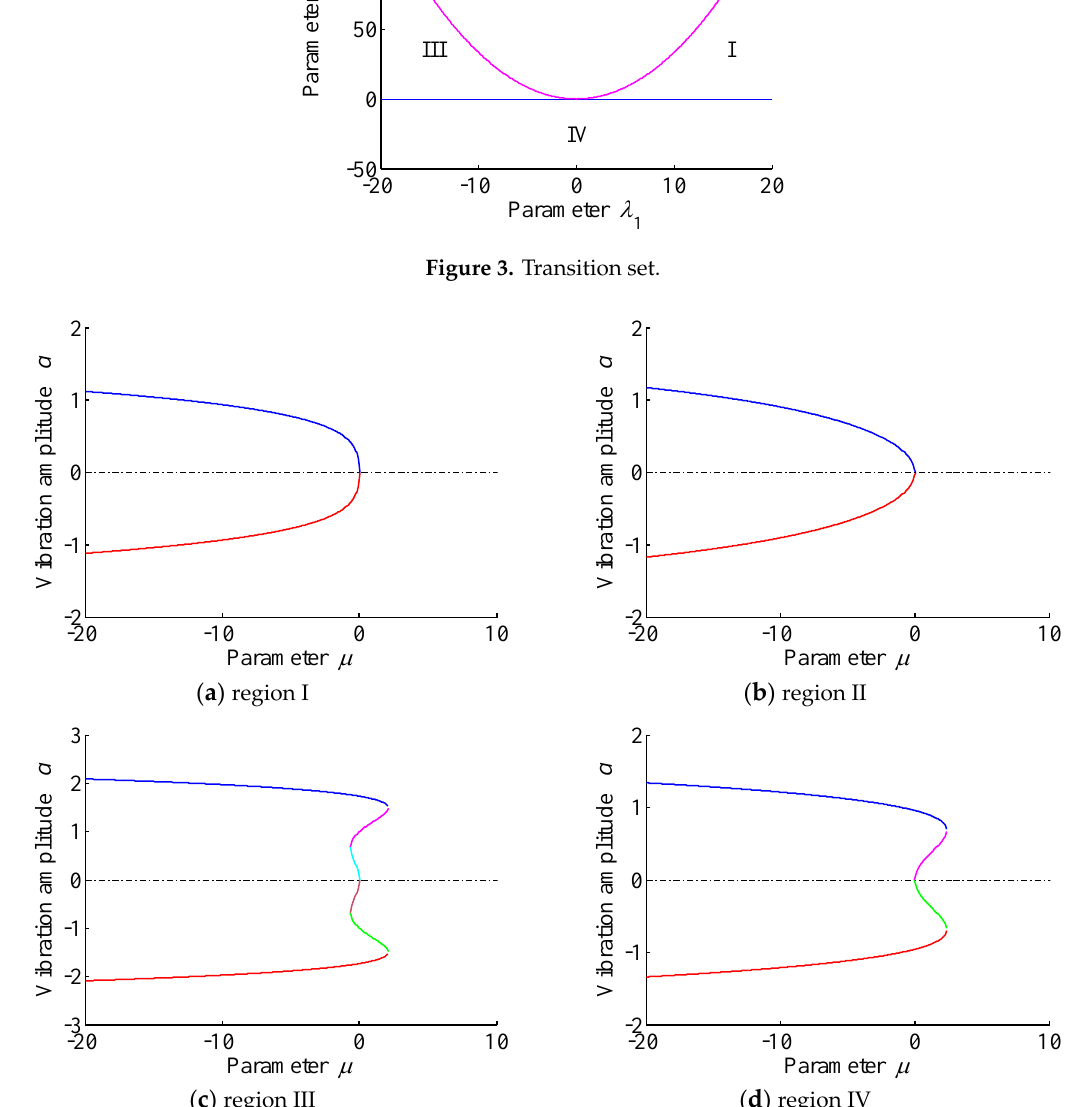
Figure 4. Topological structure of bifurcation curves in different subregions.